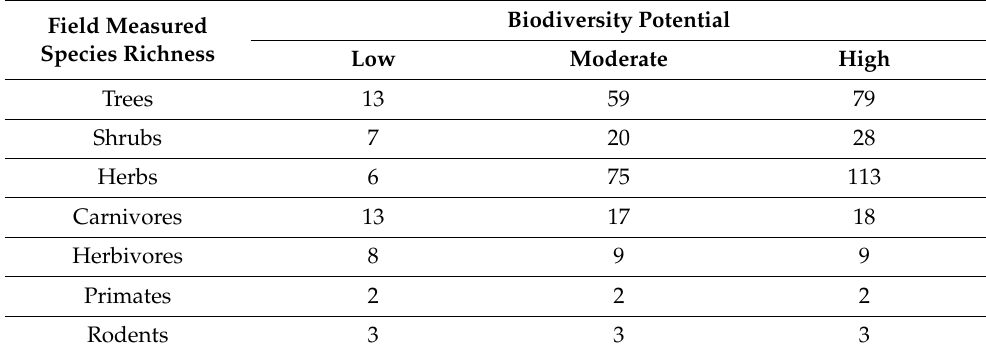
Table 3. Field measured species richness in biodiversity potential classes.